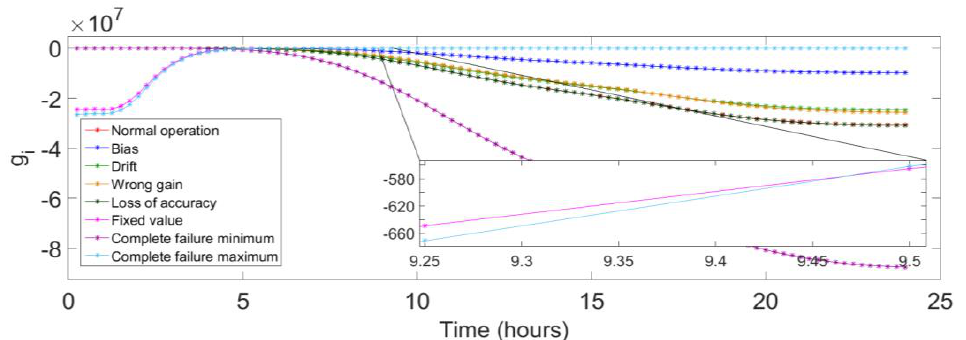
Figure 9. Complete failure maximum diagnosis: graphs of the FDA discriminant functions gi(x) for each of the normal and seven fault classes, along the 24 h of the 140th day and the detailed representation revealing the class of the observations and the time moment of the firm fault type identification.